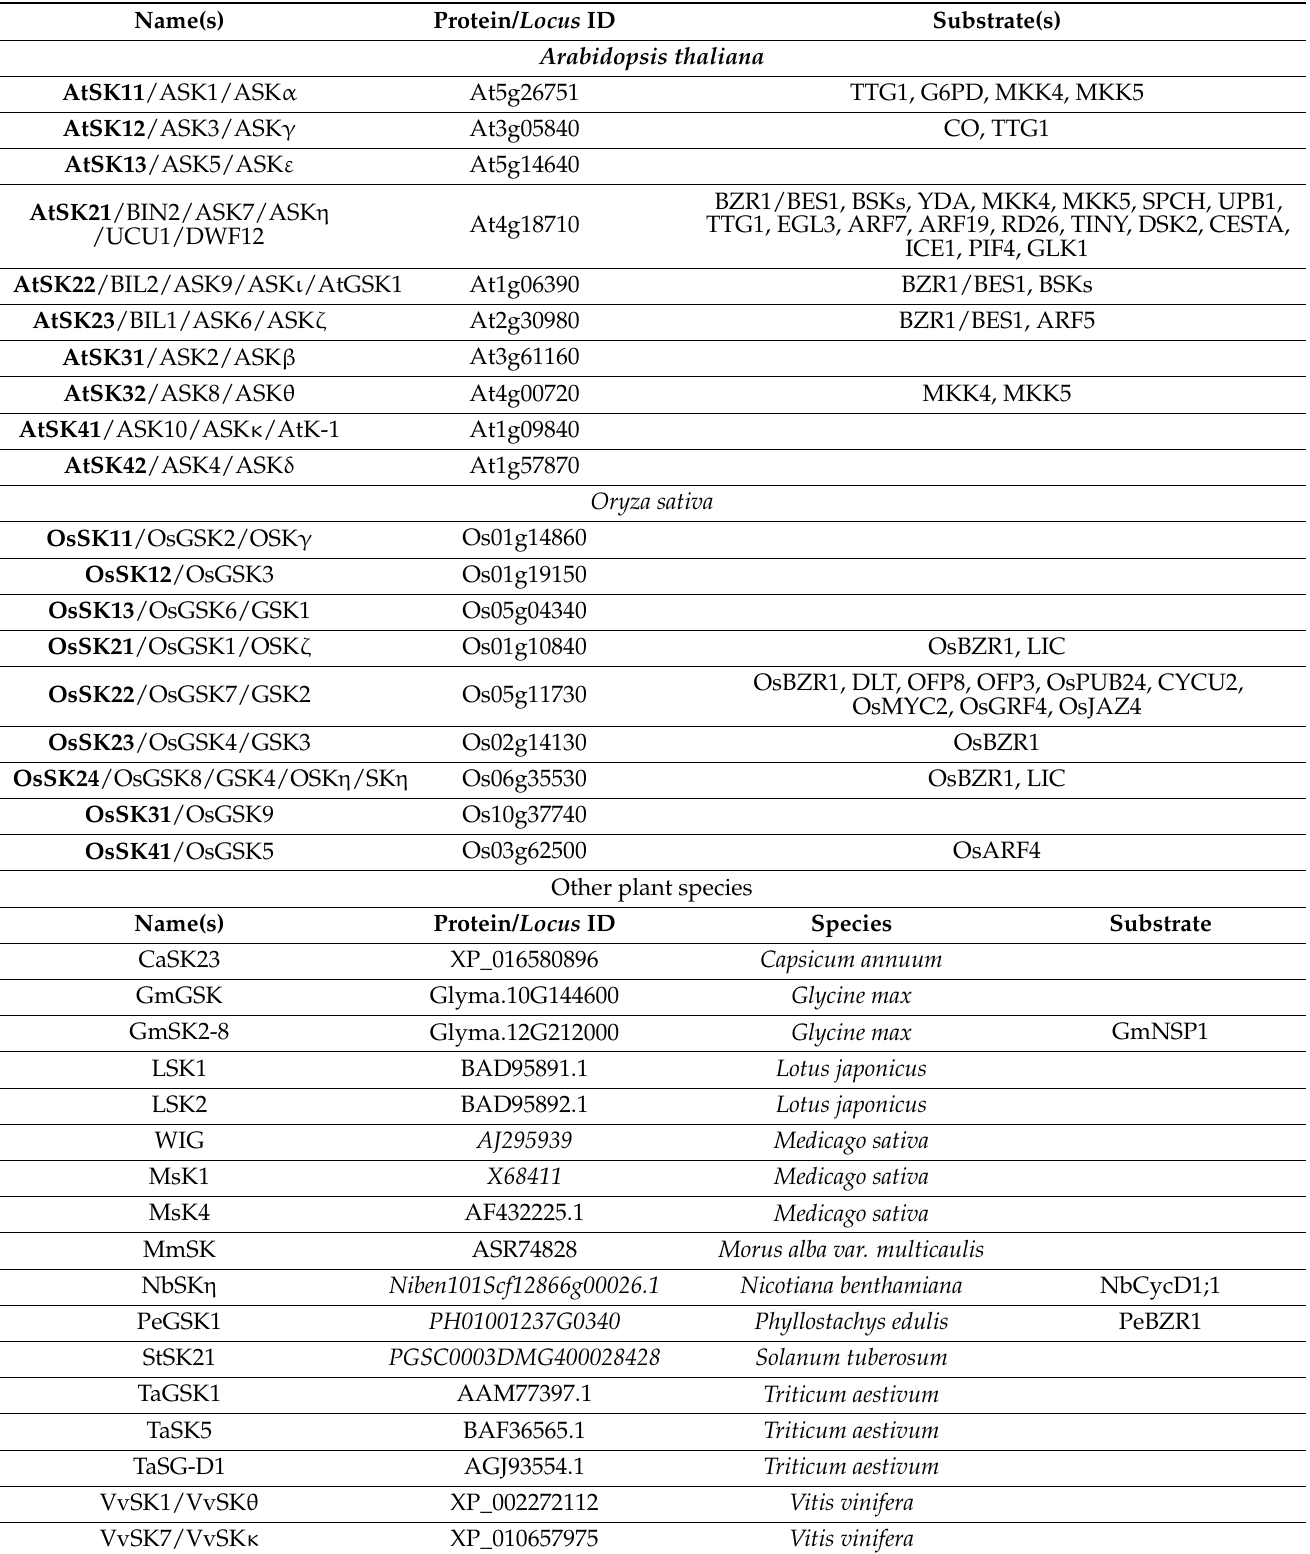
Table 1. Names, Gene/Protein IDs, and Known Substrates of the Plant GSK3-Like